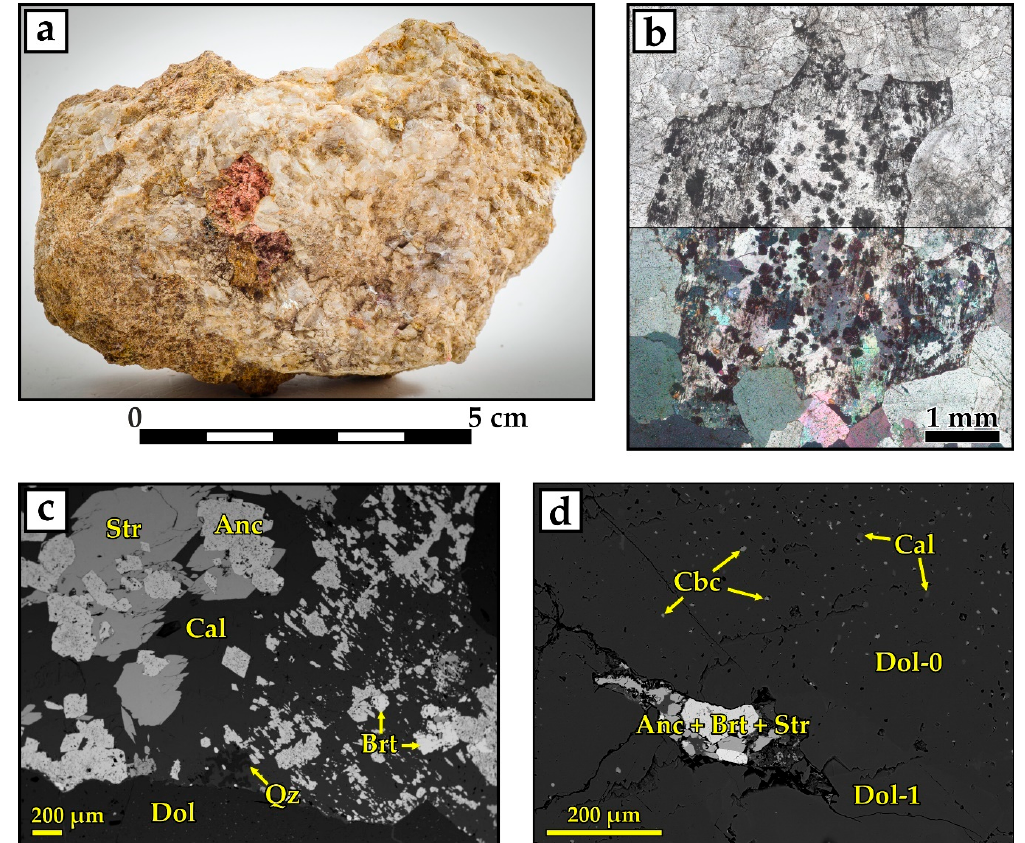
Figure 3. Least altered magnesiocarbonatite. ( a ) Whole-rock sample with red colored polymineral pseudomorphs in the dolomite matrix. ( b ) General view and ( c ) a fragment of the polymineral pseudomorph; ( d ) Fe–Mn–poor dolomite (Dol-0) with a variety of inclusions (the dark grey inclusions are calcite; the light ones are carbocernaite and burbankite). Near the cracks, Dol-0 is replaced by Fe- Mn-rich inclusion-free Dol-1. Photomicrograph ( b ) in transmitted light [top—in plane-polarized light, bottom—in cross-polarized light], ( c , d ) in backscattered electrons (BSE).